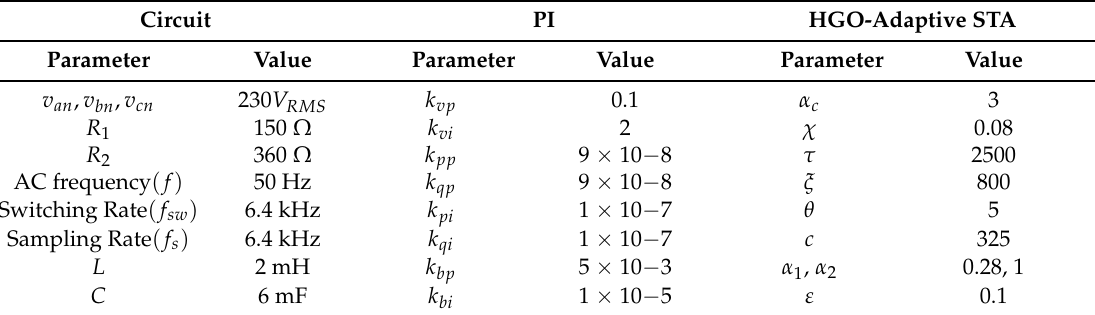
Table 2. Circuit and control parameters.